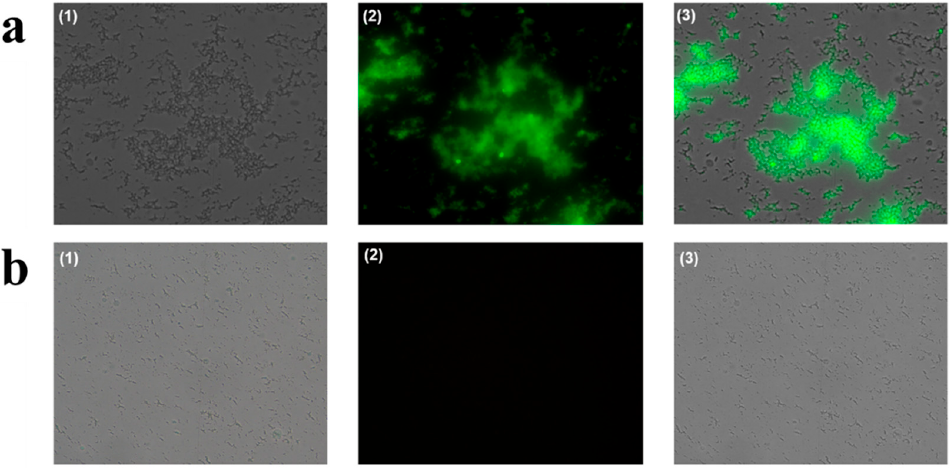
Figure 3. Fluorescence microscope images obtained in the presence ( a ) and absence ( b ) of DNA. (1) Optical images, (2) fluorescent images, (3) merged images.